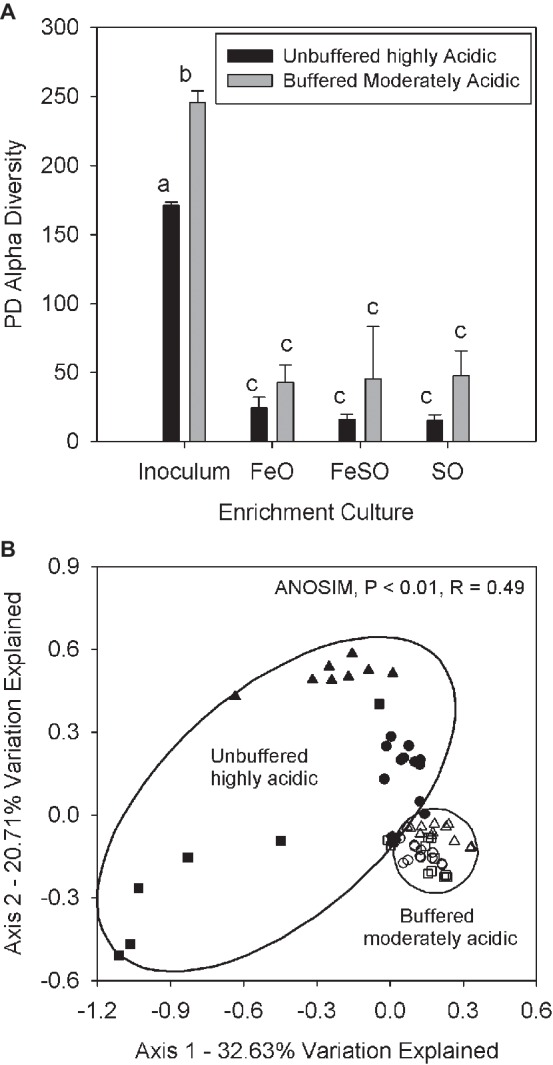
(A) Alpha diversity in the FeO, FeSO, and SO microcosm treatments (both the unbuffered highly acidic treatment and the buffered moderately acidic systems) and in the inoculum used for all microcosms. Alpha diversity values were averaged across all replicates and time points. Bars with different letters signify significant differences (p < 0.01) between mean values. Error bars indicate one standard deviation. (B) PCoA plot of microbial communities from both microcosm systems including all replicates and time points and from the inoculum. Coordinates were determined by UniFrac weighted distance metric. Sample groups are denoted as the inoculum community (x), the buffered moderately acidic system samples are represented by open symbols [FeO (○), FeSO (∆), SO (□)] and the unbuffered highly acidic system samples are represented by solid symbols [FeO (●), FeSO (▲), SO (■)].